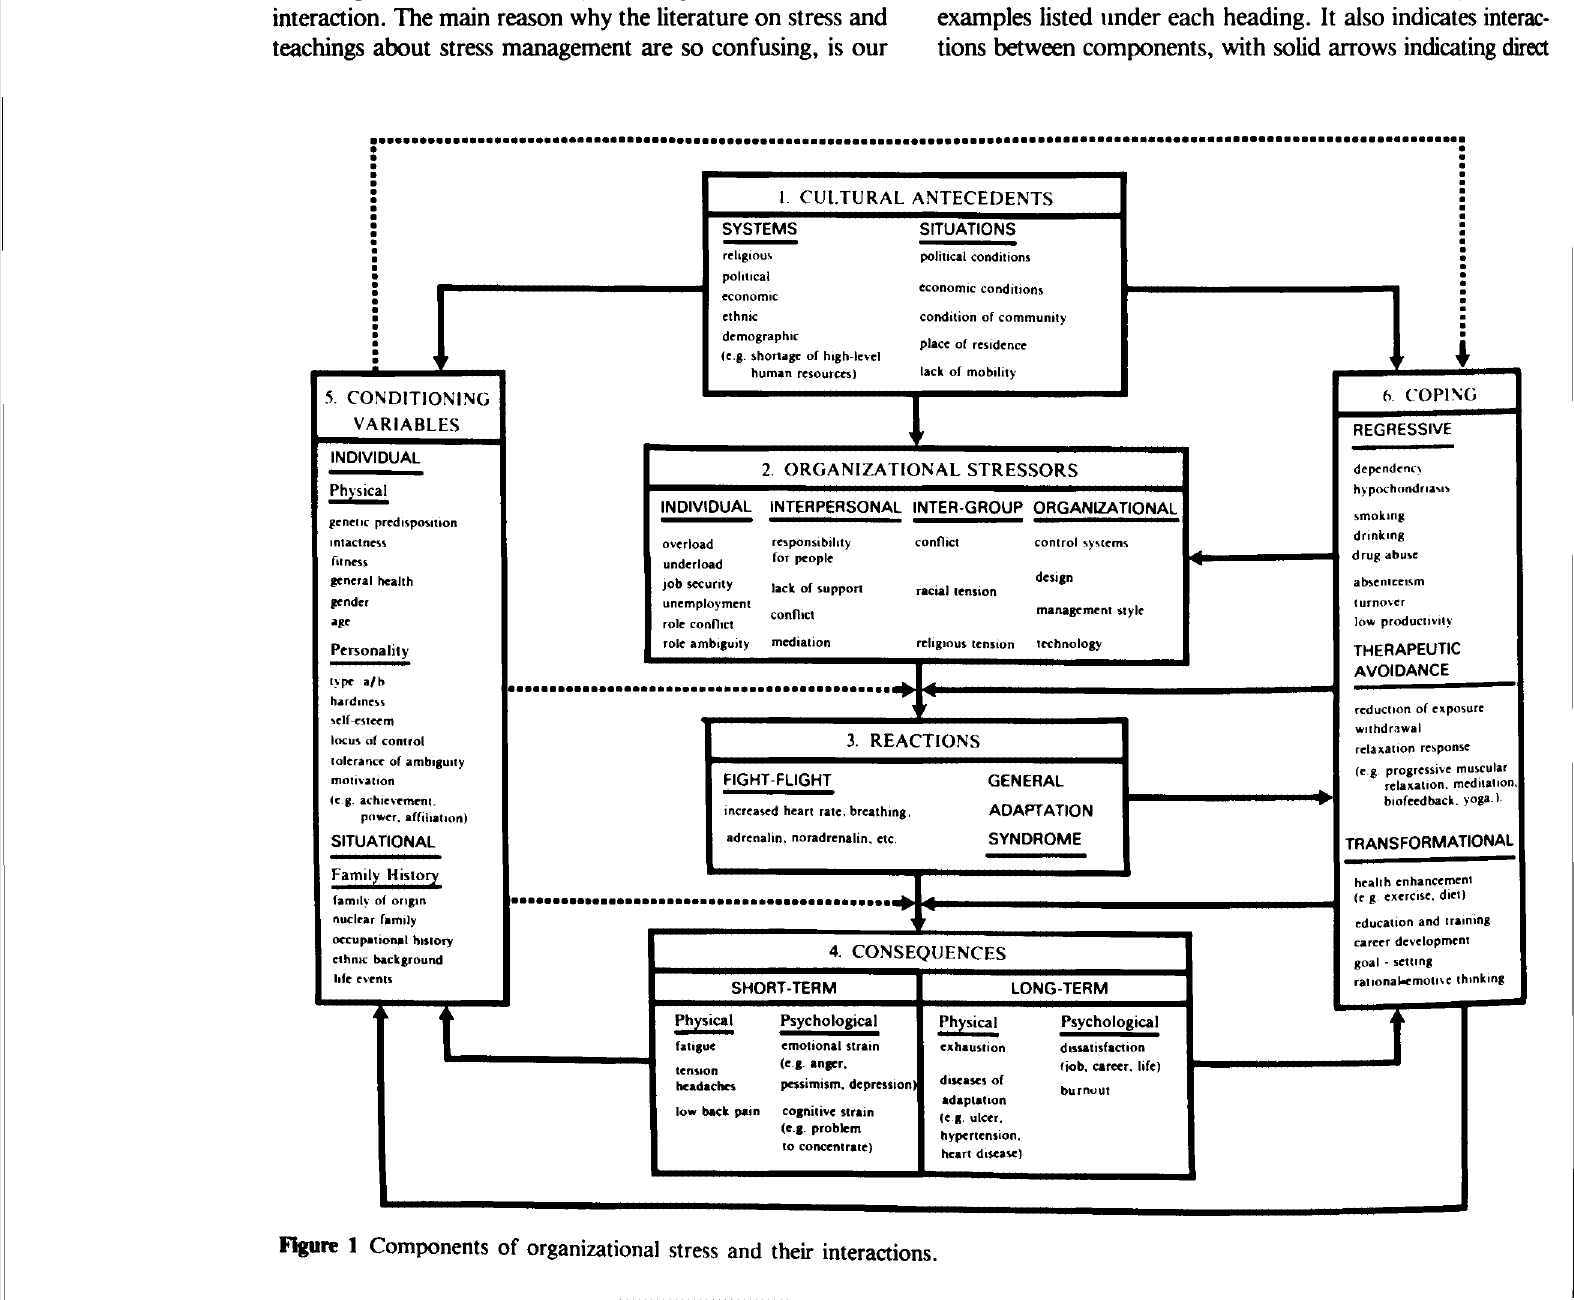
Figure 1 Components of organizational stress and their